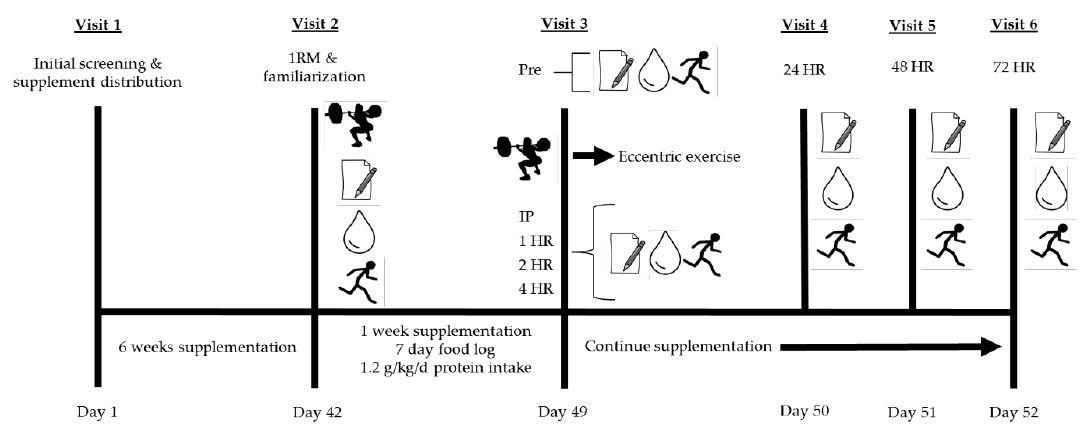
Figure 1. Study design overview. Participants (n = 32) were randomly assigned to consume 2, 4, or 6 g/day fish oil or placebo. performance (vertical jump, 40-yard dash, T-test agility, maximal voluntary isometric contraction) .